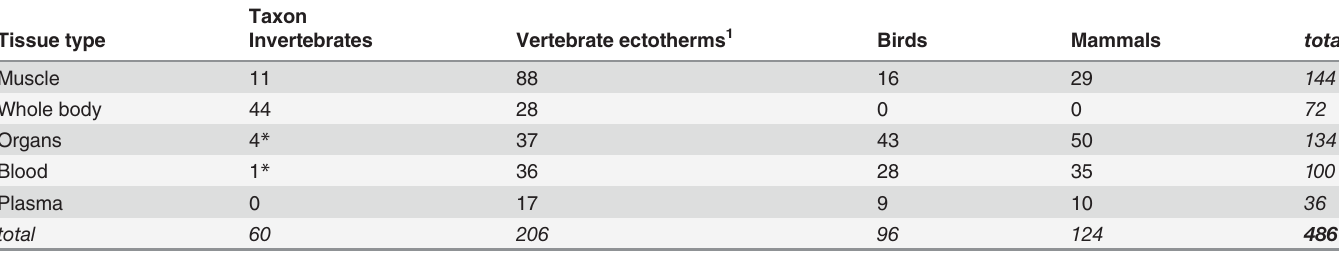
Table 2. The number of half-life estimates for each tissue type-taxon combination (hereafter referred to as ‘ group ’ ). Taxon Tissue